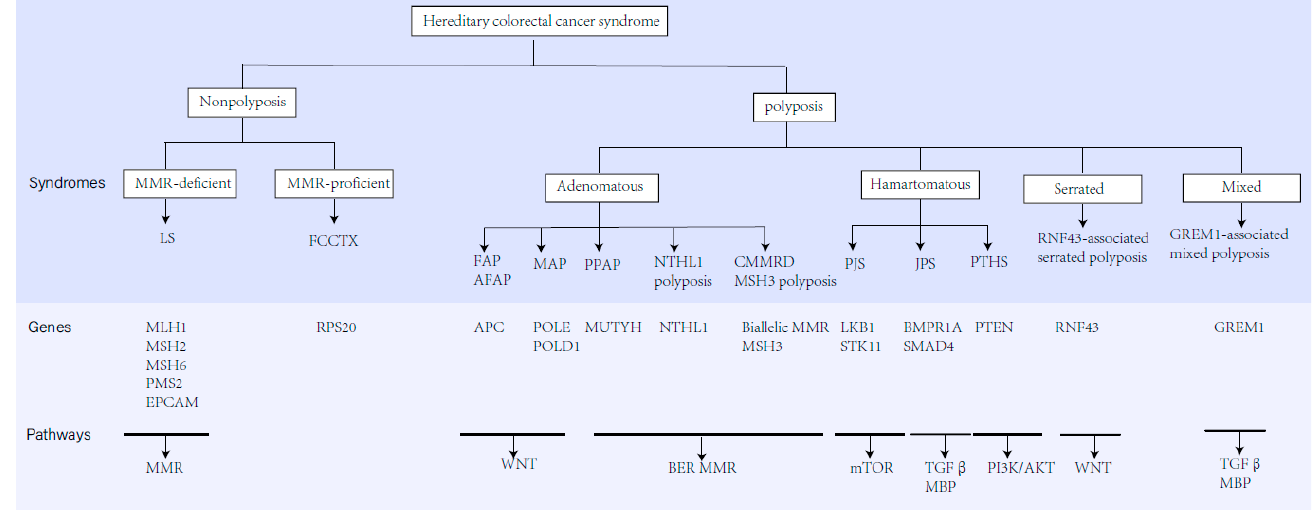
Figure 1. The classification, predisposing genes, inheritance, and related molecular pathways of hereditary CRC syndromes.